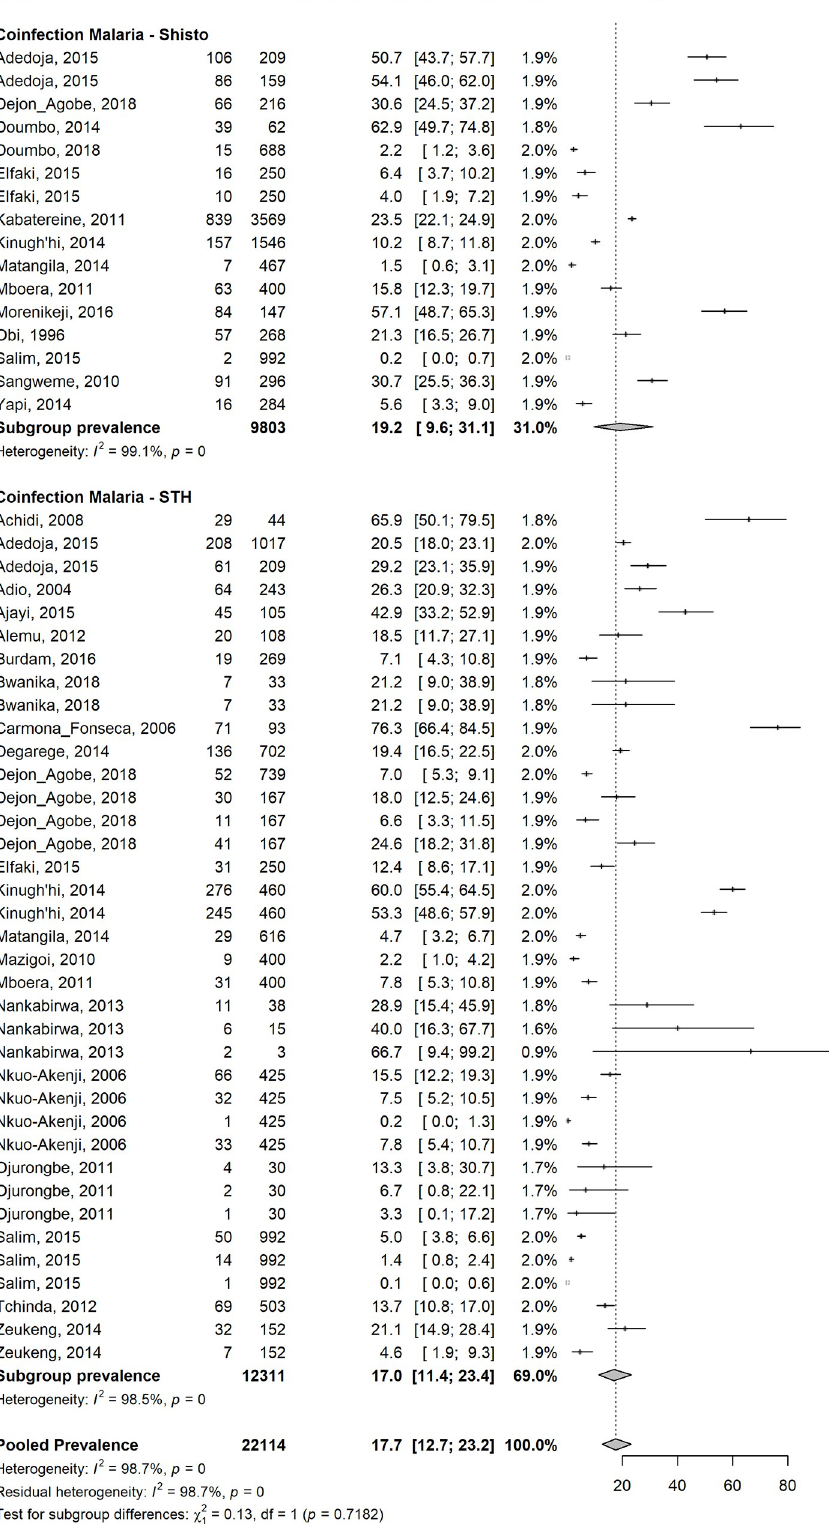
Fig 2. Forest plot showing overall pooled prevalence of Plasmodium -helminth co-infections among children living in LMIC in studies which evaluated the prevalence of both groups of infection. https://doi.org/10.1371/journal.pntd.0009138.g002 PLOS NeglectedTropical Diseases | https://doi.org/10.1371/journal.pntd.0009138 February 18,